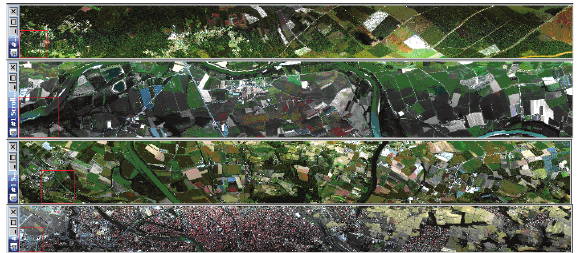
Figure 1: True color composition of AHS images acquired in the CEFLES-2 campaign (mission 3, September 2009). From top to bottom: “Les Landes-P01BS”, “Les Landes-P03BS”, “Toulouse- Forest-F01BS,” and